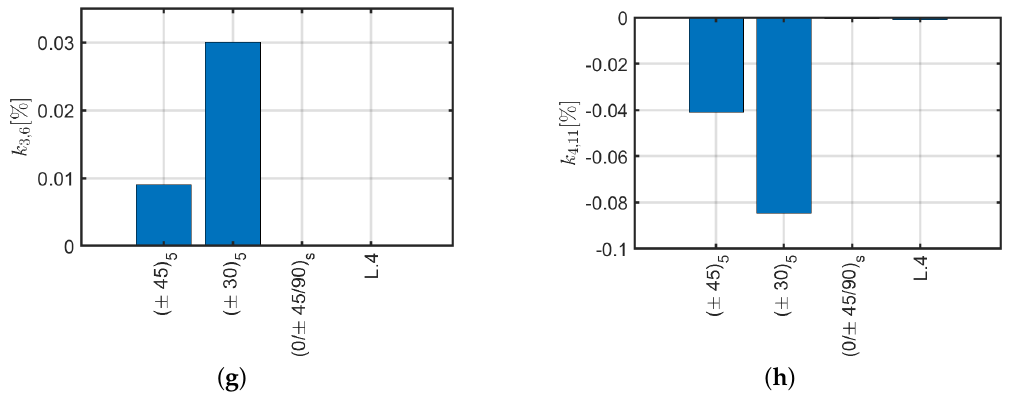
Figure 14. Comparison among stiffness components ( a – h ) for angle-ply, quasi-isotropic and L .4 laminates with L = 1 m respect to the orthotropic scheme (0).